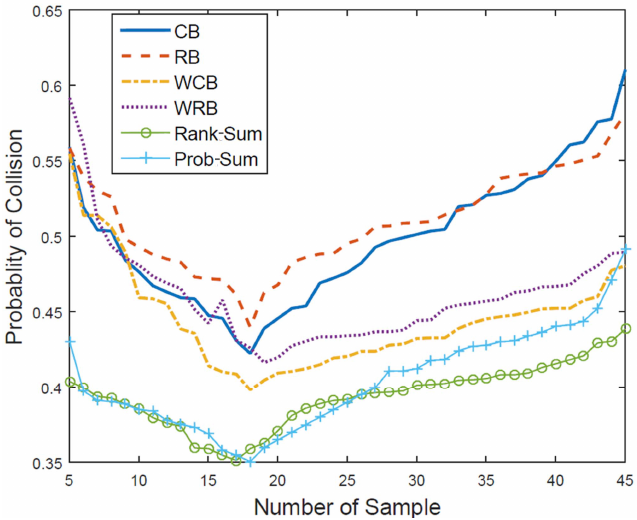
Figure 15. Comparison of collision probability according to the number of samples (reasoning period = 20, sample interval =